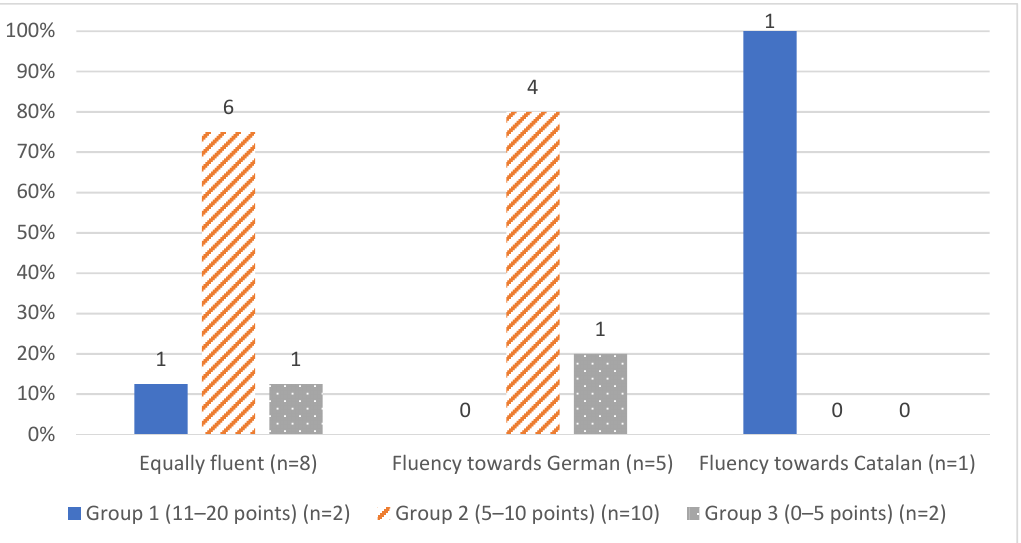
Figure 7. Children’s fluency and parent’s knowledge of the L2 Catalan.